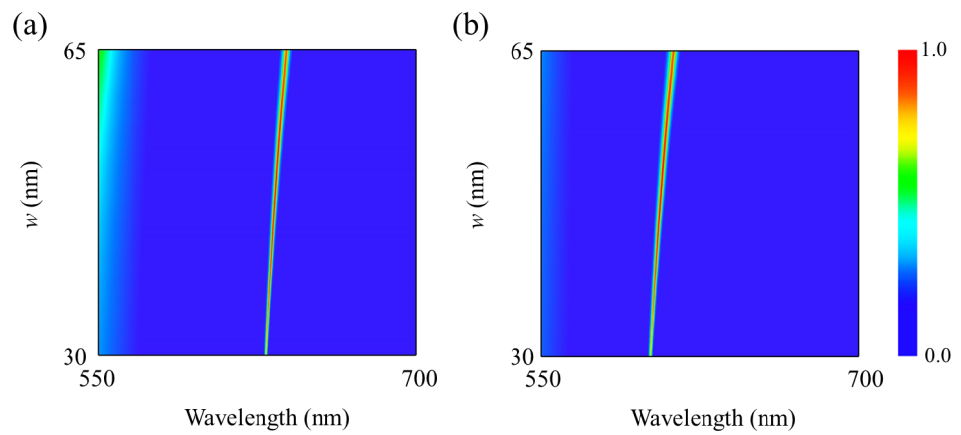
Figure 3. Absorption spectra of the proposed structure as a function of wavelength and width w of nanoring for polarizations along ( a ) [100] and ( b ) [001] crystalline directions of α -MoO 3 . h = 300 nm, p = 500 nm, and t = 105 nm.